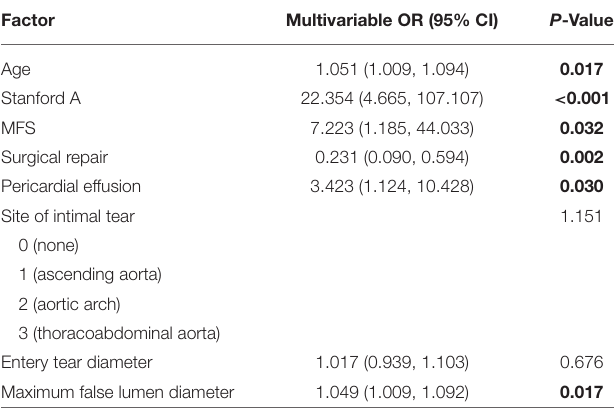
TABLE 2 | Multivariate logistic analysis of potential prognostic factors in AAD patients.